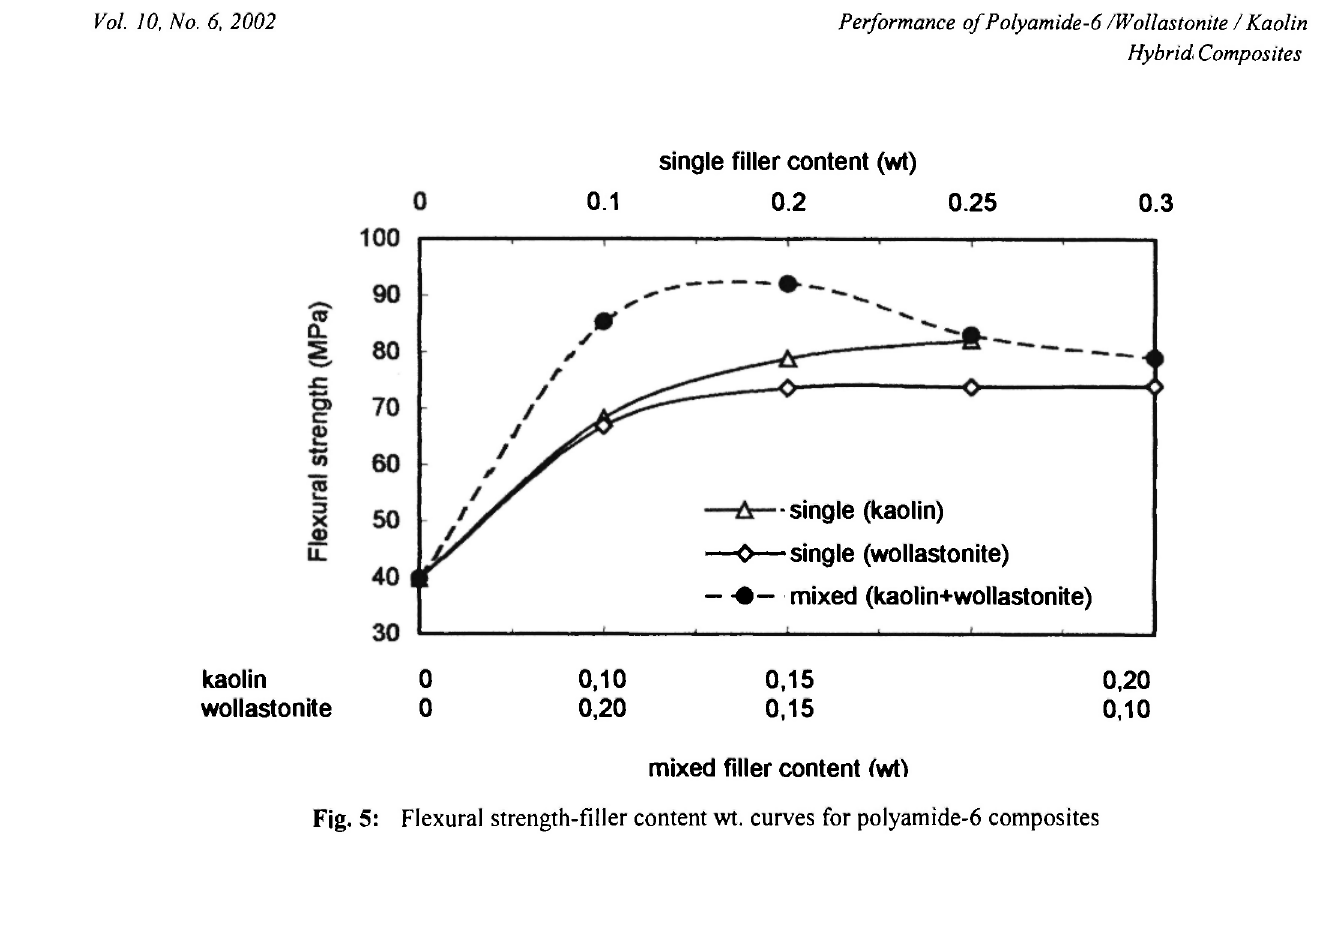
Fig. 5: Flexural strength-filler content wt. curves for polyamide -6 composites